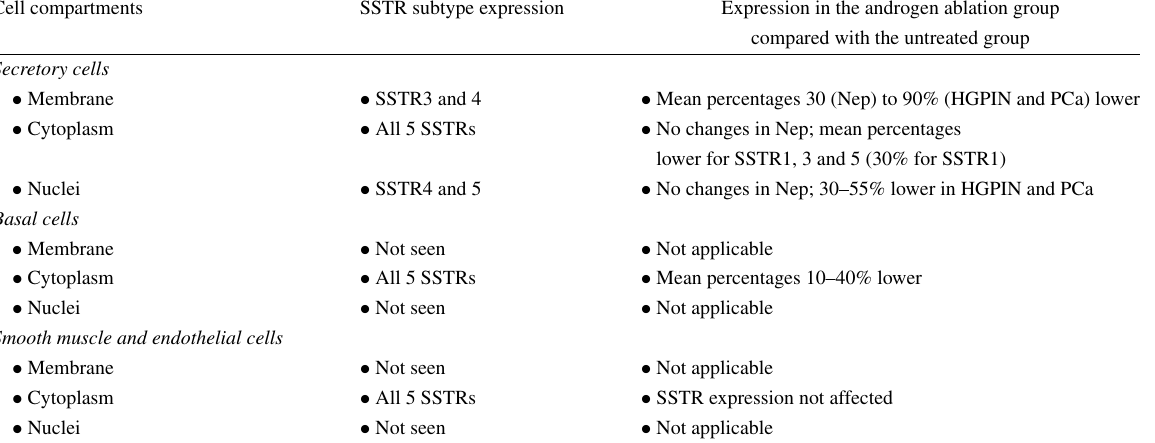
Summary of the immunohistochemical expression and localization of somatostatin receptor subtypes in prostate cancer following complete androgen ablation Cell